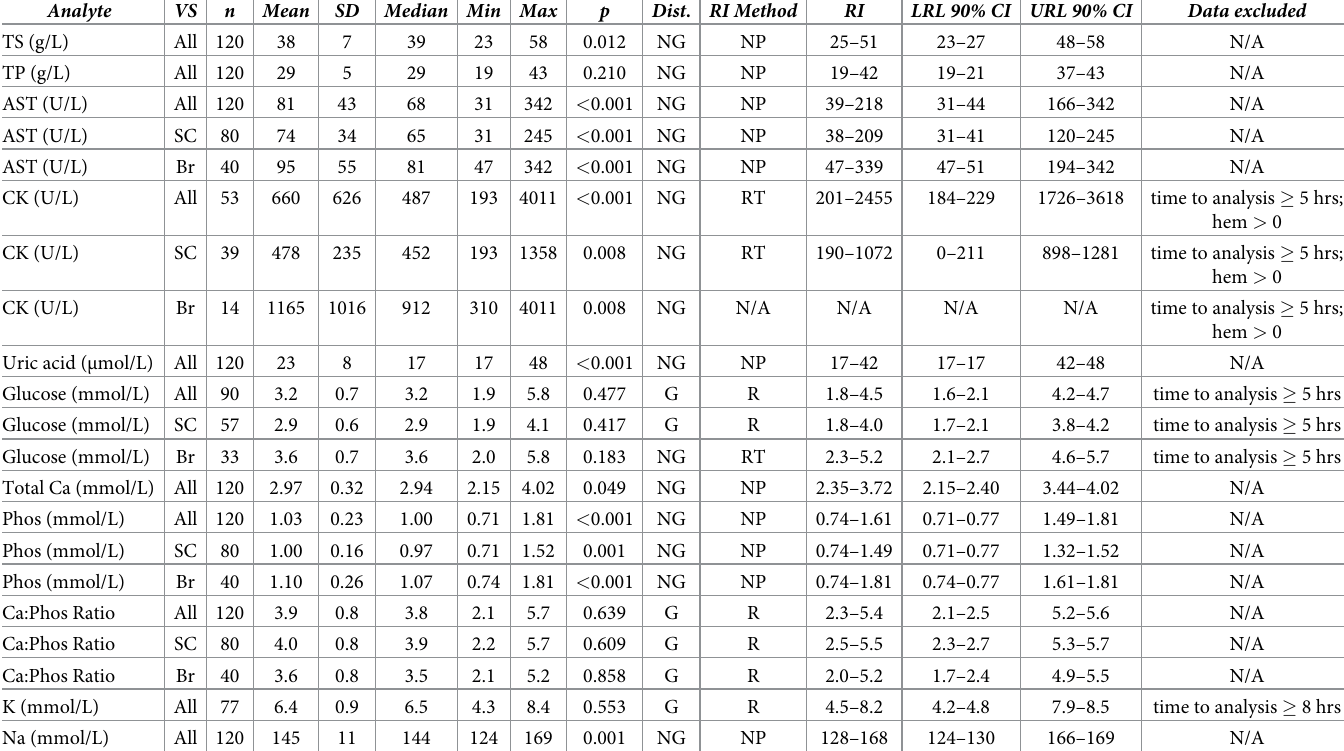
Table 2. Subadult radiated tortoise biochemistry reference intervals and descriptive statistics based on clinically healthy individuals living in a rehabilitation setting within their natural range.